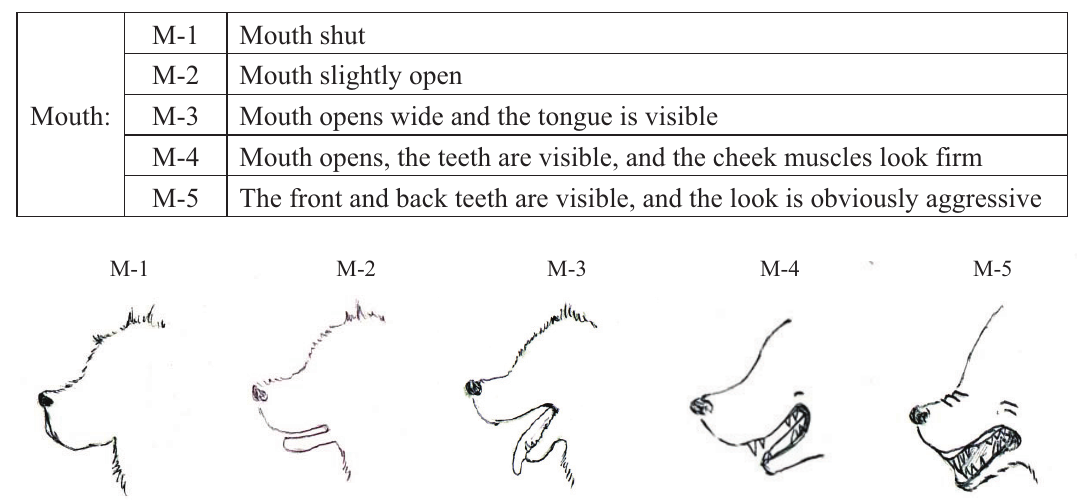
Figure 2. Categories of mouth (M) expressions in dogs during their training.